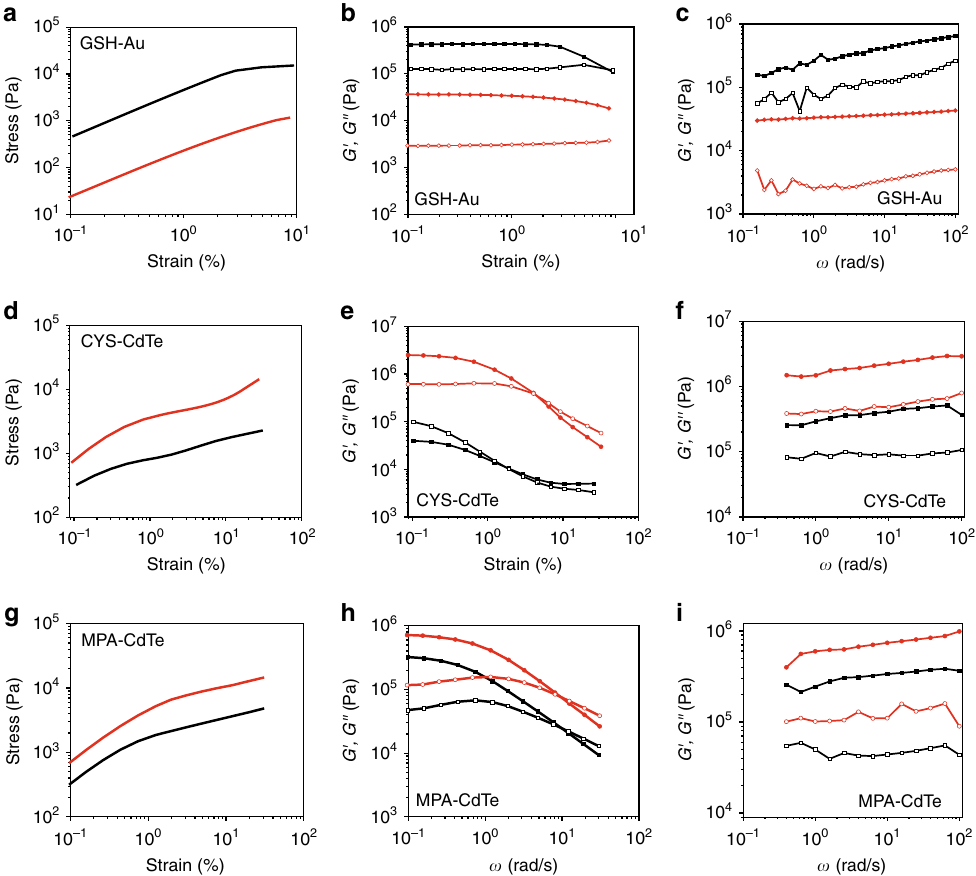
Fig. 5 Mechanical characterization of GSH-Au hydrogels, CYS-CdTe hydrogels and MPA-CdTe hydrogels. Oscillatory stress/strain ( a ), continuous step moduli/strain ( b ) and rheological dynamic oscillatory frequency sweep ( c ) of GSH-Au hydrogels (black line: Au, ~ 3 nm, red line: Au, ~ 8 nm). Oscillatory stress/strain ( d ), continuous step moduli/strain ( e ) and rheological dynamic oscillatory frequency sweep ( f ) of CYS-CdTe hydrogels (black line: ~ 3.2 nm, red line: ~ 3.7 nm; solid symbol: G ′ , empty symbol: G ″ ). Oscillatory stress/strain ( g ), continuous step moduli/strain ( h ) and rheological dynamic oscillatory frequency sweep ( i ) of MPA-CdTe hydrogels (black line: ~ 2.7 nm, red line: ~ 3.1 nm; solid symbol: G ′ ( ω ), empty symbol: G ″ ( ω